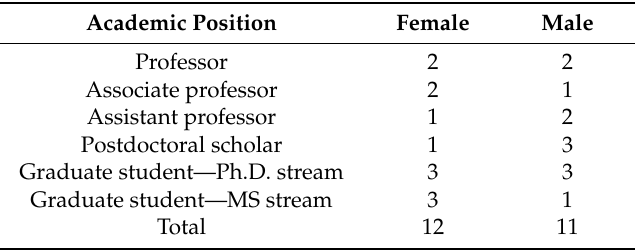
Table 1. Interview sample; by academic position and gender (Total N =